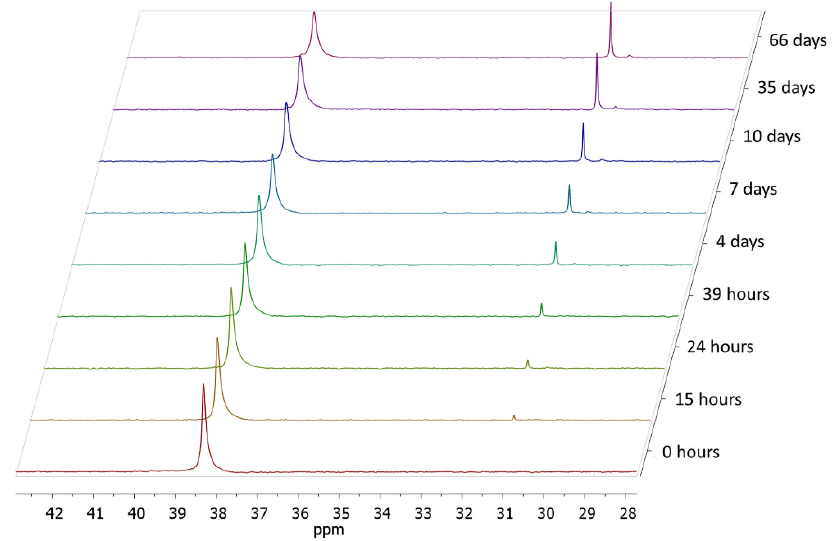
Figure 3. The 31 P NMR spectra of p(PEtEPMA) in alkaline solution (pH ~ 10) at different times.